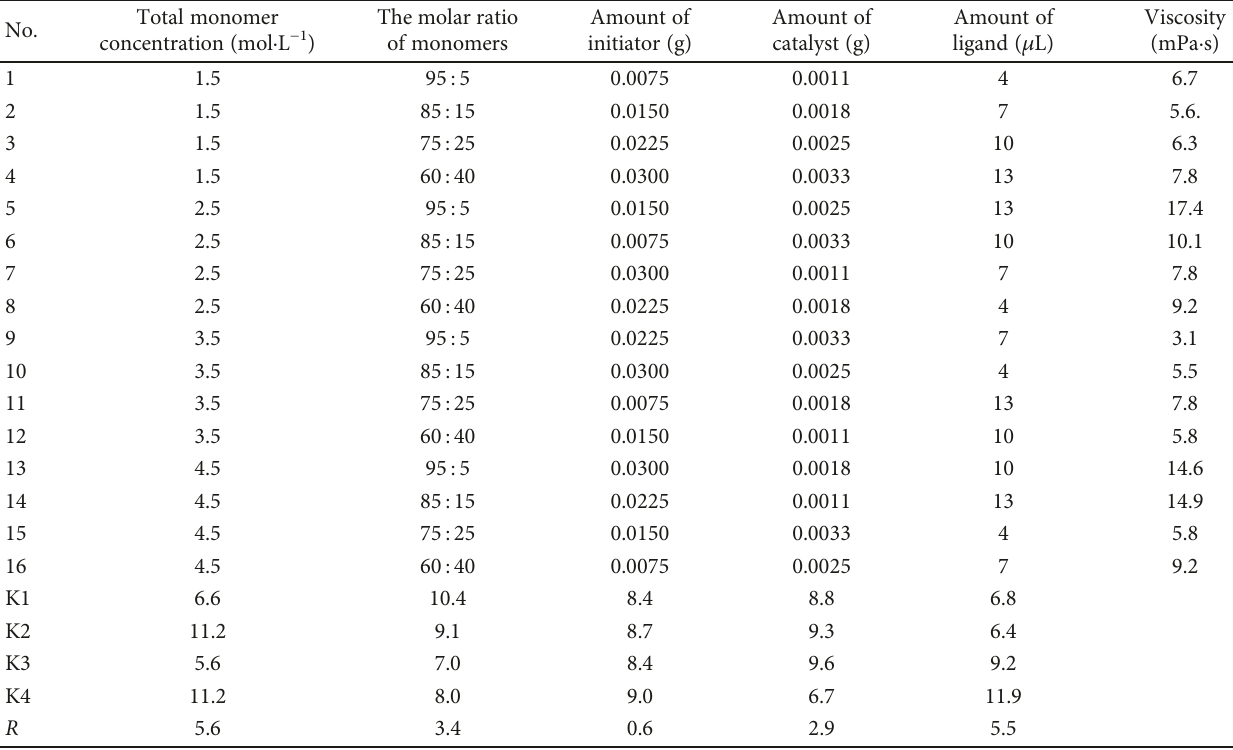
Table 2: Results of the orthogonal experiments (L5 4 ).